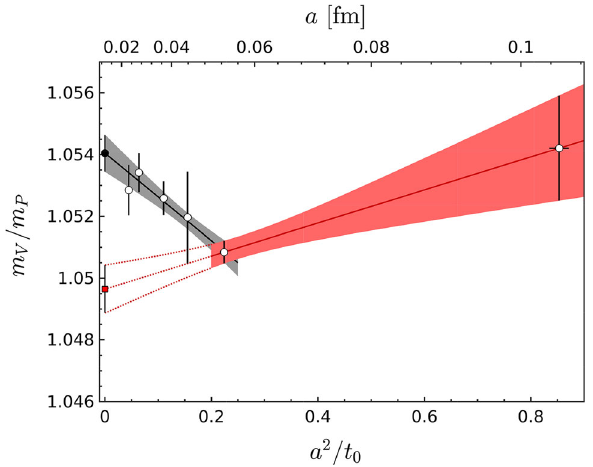
Fig. 8 Continuum extrapolations of m V / m P . One extrapolation includes only data with a 2 / t 0 < 0 . 25, the other uses only coarse lattices with a 2 / t 0 > 0 . 2. The continuum limitsdiffer significantly between the two extrapolations Table5 Latticespacingsinphysicalunitsonourquenchedanddynam- ical ensembles, determined in two different ways Ensemble a L 1